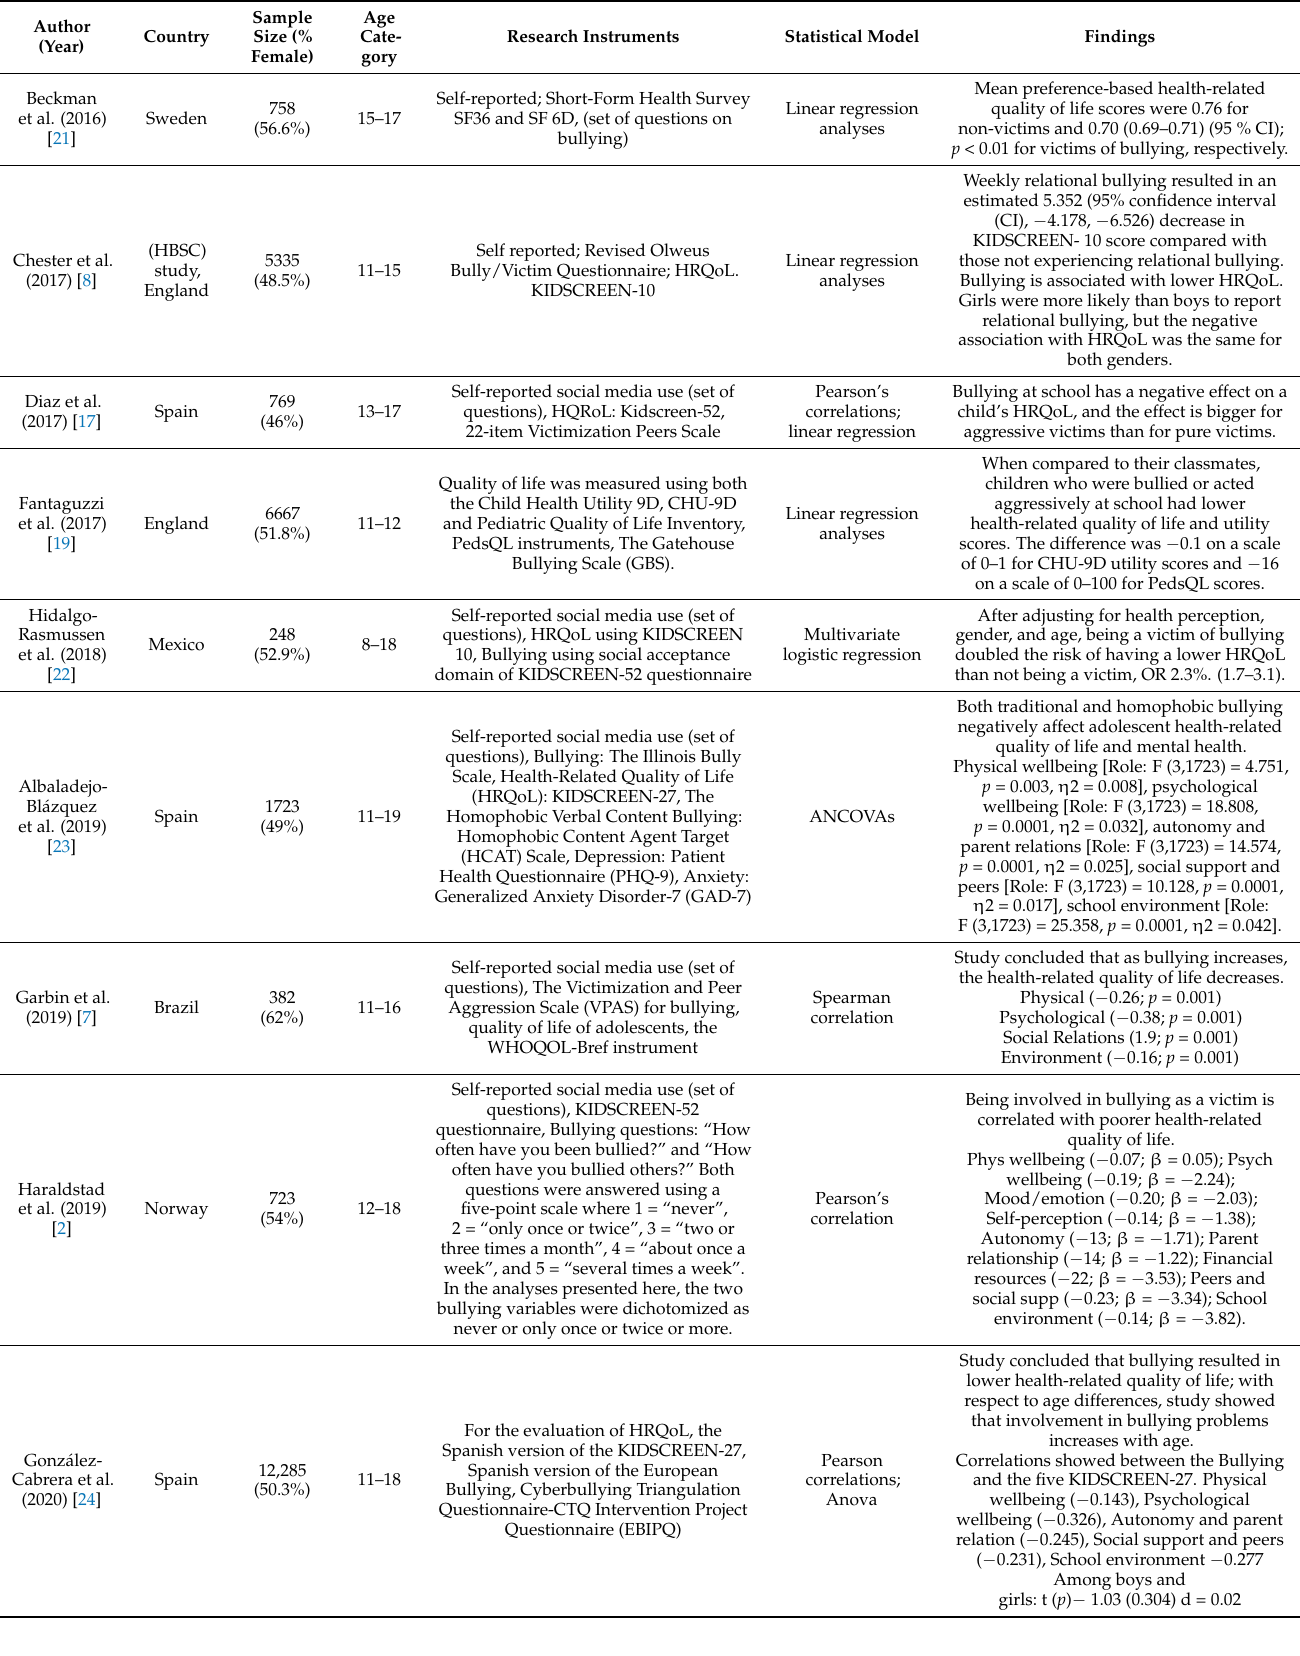
Table 2. Reviewed studies of HRQOL and bullying according to sample, method, results, and